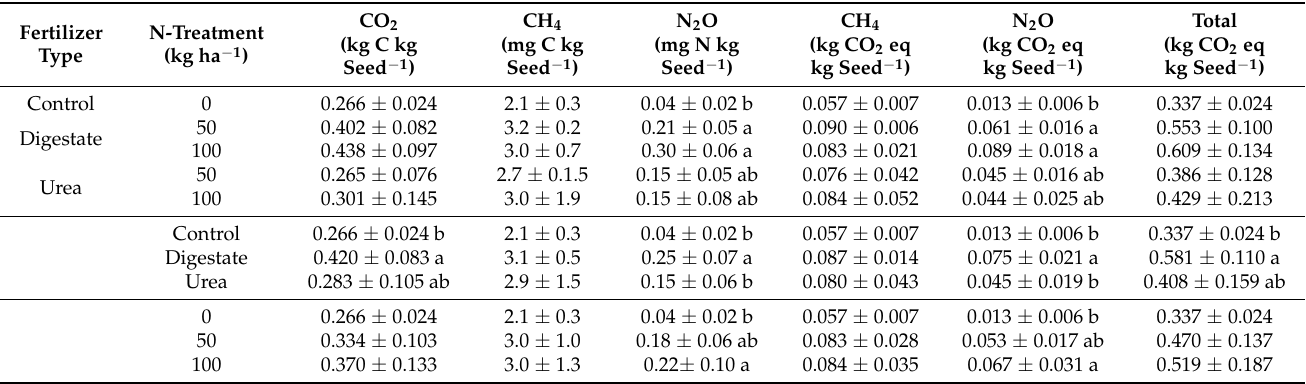
Table 4. Yield-scaled emissions (CO 2 , CH 4 , and N 2 O) per kg of quinoa seed produced and Global Warming Potential (GWP) (kg CO 2 eq kg seed − 1 ) of each